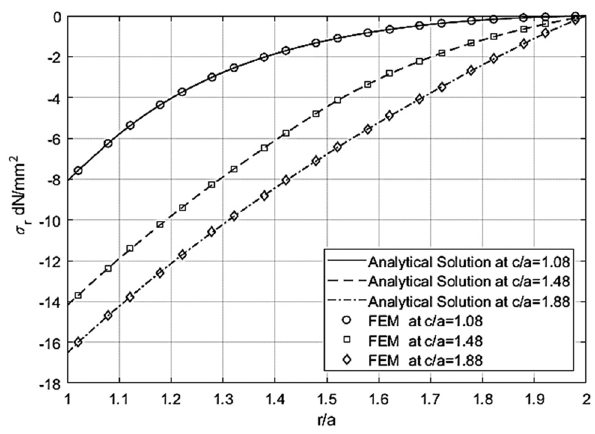
Figure 8: Distribution of radial stresses in an elastic – plastic cylinder subjected to internal pressure when β −0.25